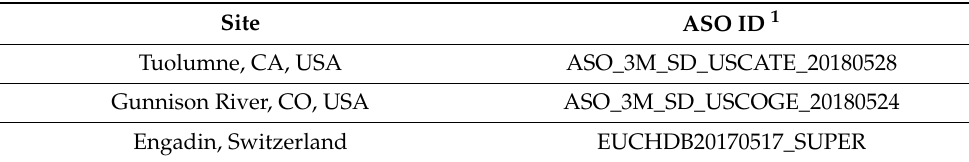
Table A1. ASO collection IDs for the sites.